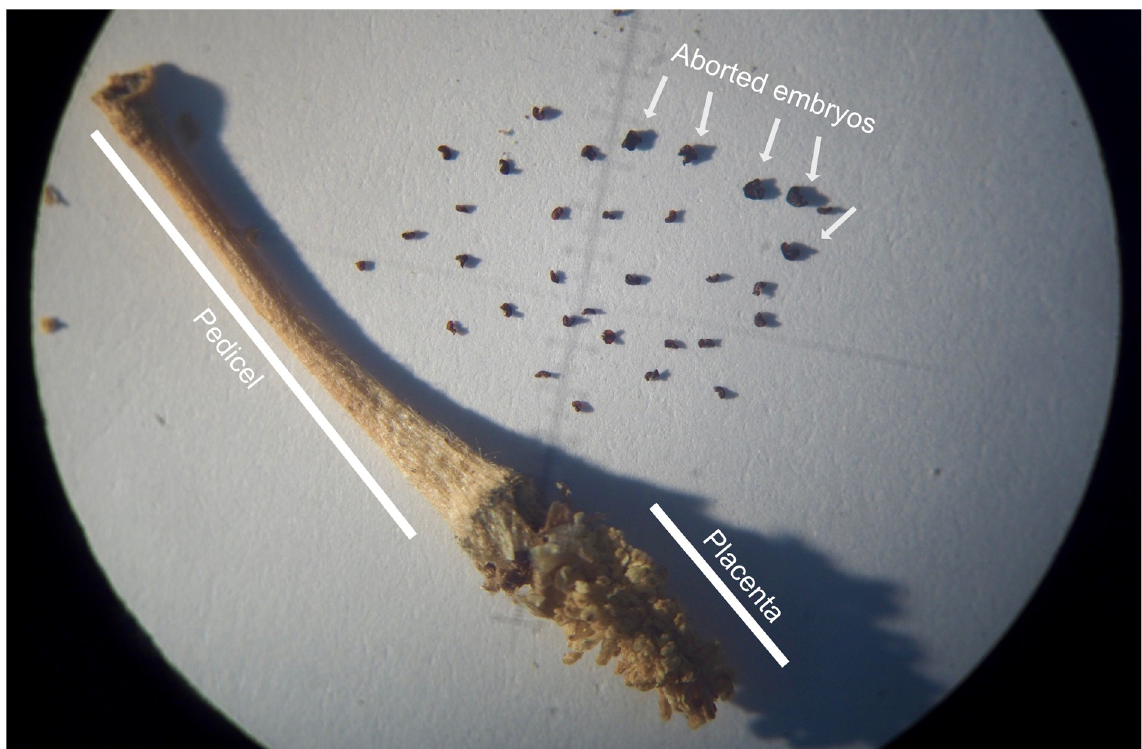
Fig 1. The mature fruit of the XY individual with the calyx, ovary wall, and seeds removed. The pedicel and placenta, both maternally derived tissues, had their DNA extracted. There were 27 non-fertilized ovules and 5 aborted embryos (arrows).